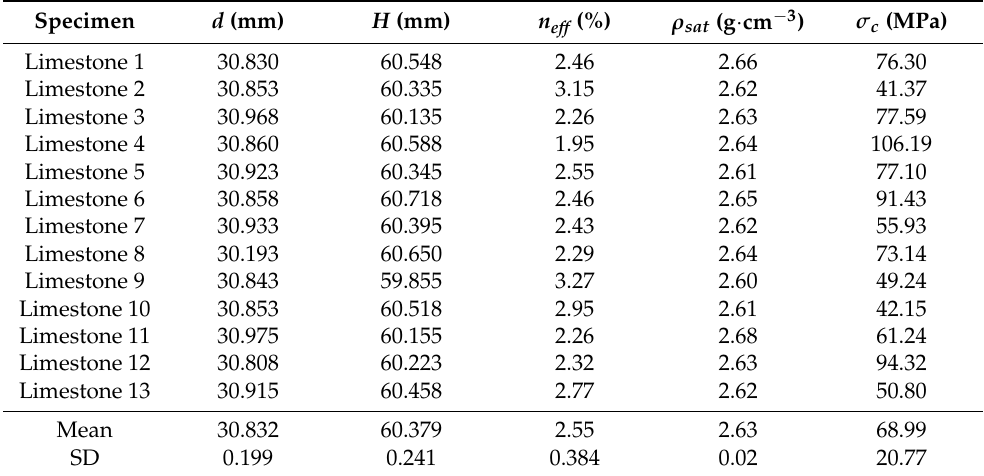
Table 4. Results of the uniaxial compressive strength, density, and porosity tests on